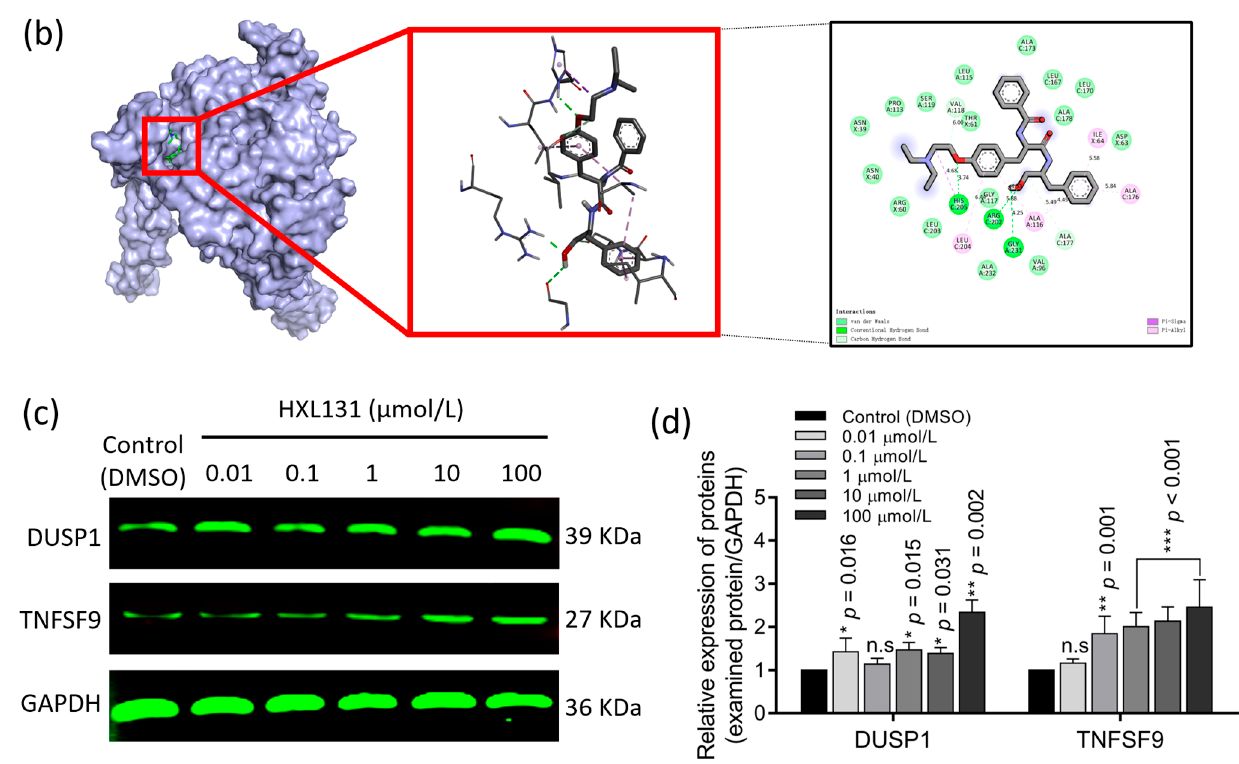
Figure 7. Validation of the two targets of HXL131 regulation, DUSP1, and TNFSF9. ( a ) Molecular docking visualization model of small-molecule ligand (compound HXL131) with the protein receptor (DUSP1). This compound formed hydrogen bonds with ASP A: 198, ASP B: 81, and ASN A: 202 amino acid residues site; ( b ) Molecular docking visualization model of the small-molecule ligand (compound HXL131) with the protein receptor (TNFSF9). The compound formed hydrogen bonds with HIS C: 205, ARG C: 202, and GLY A: 231 amino acid residue site; ( c ) The Odyssey infrared imaging system shows a band map; ( d ) Statistical plots of the relative expression of DUSP1 and TNFSF9 proteins. The targeted binding ability of HXL131 to target the DUSP1 and TNFSF9 proteins was verified by ( c , d ) when we were using a cellular thermal shift assay (CETSA). Values are mean ± SD ( n = 3). * p < 0.05, ** p < 0.01, *** p < 0.001 vs. Control (DMSO) group; n.s, non-significant. Multiple t -tests and two-way ANOVA were used for statistical analysis.